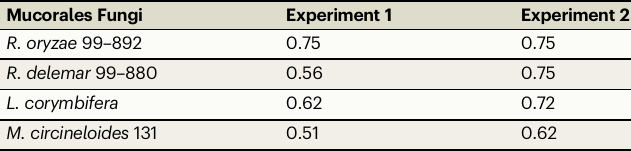
Table 3 | FIC indices of two different experiments showing BRI + POSA combination against Mucorales fungi Mucorales